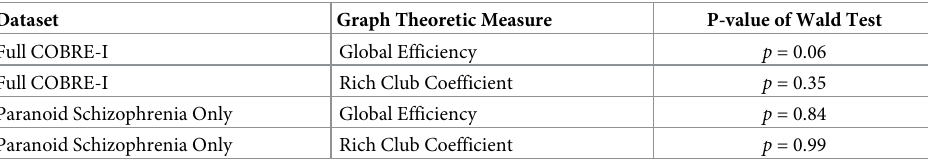
Table 4. Analysis of COBRE dataset—Global efficiency and rich